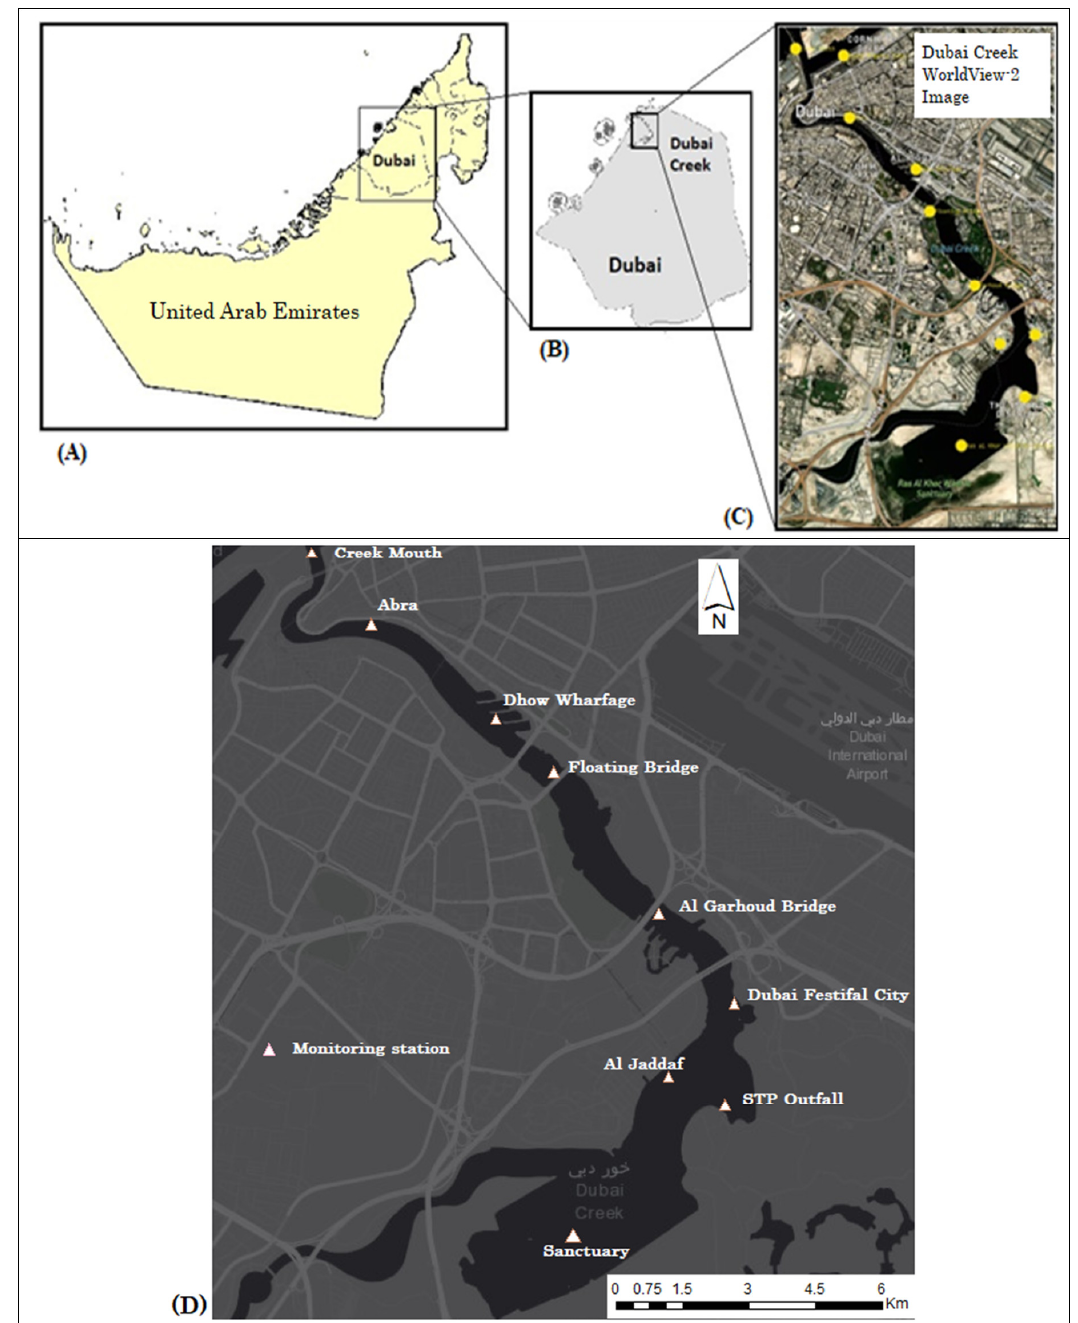
Figure 1. Study Area and Monitoring Stations: ( A ) location of Dubai within the UAE, ( B ) location of the Dubai Creek in Dubai, ( C ) displays the Dubai Creek on the georeferenced WorldView-2 image used in the study as well as the locations of the water quality monitoring stations, and ( D ) location and the names of the monitoring stations.